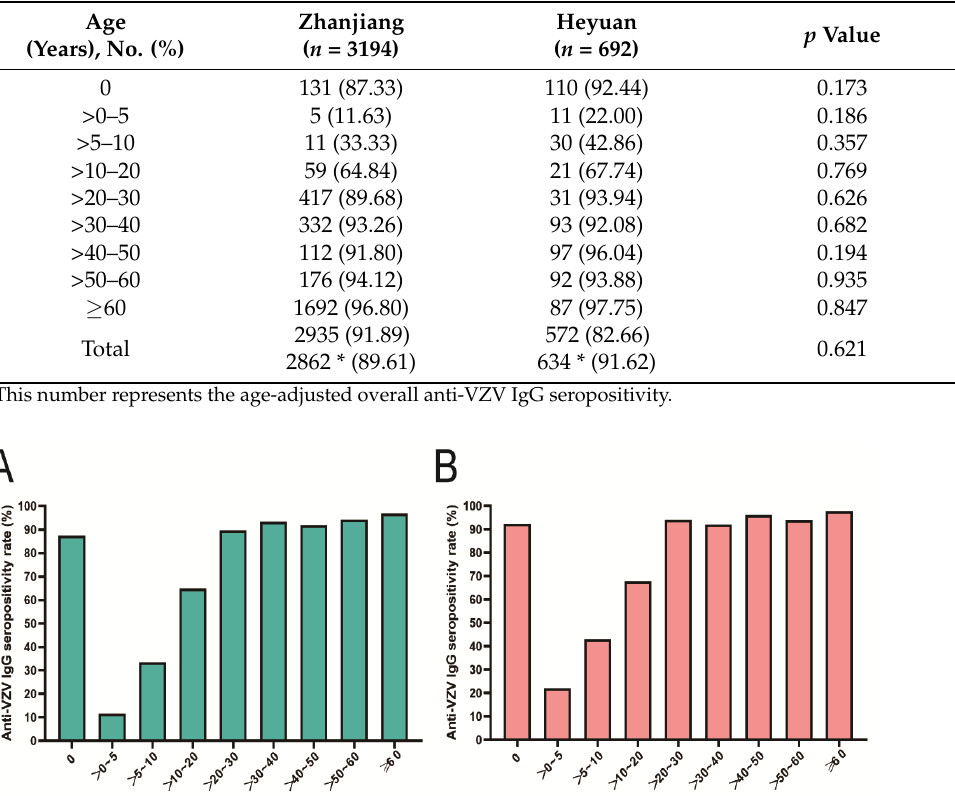
Table 1. Seroprevalence of anti-VZV IgG in non-VarV-vaccinated participants.